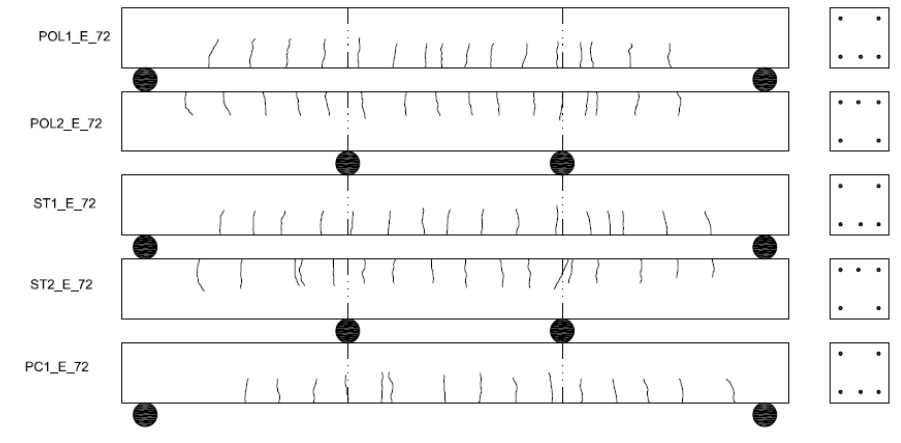
Figure 1. Sustained loading scheme used in the frames.